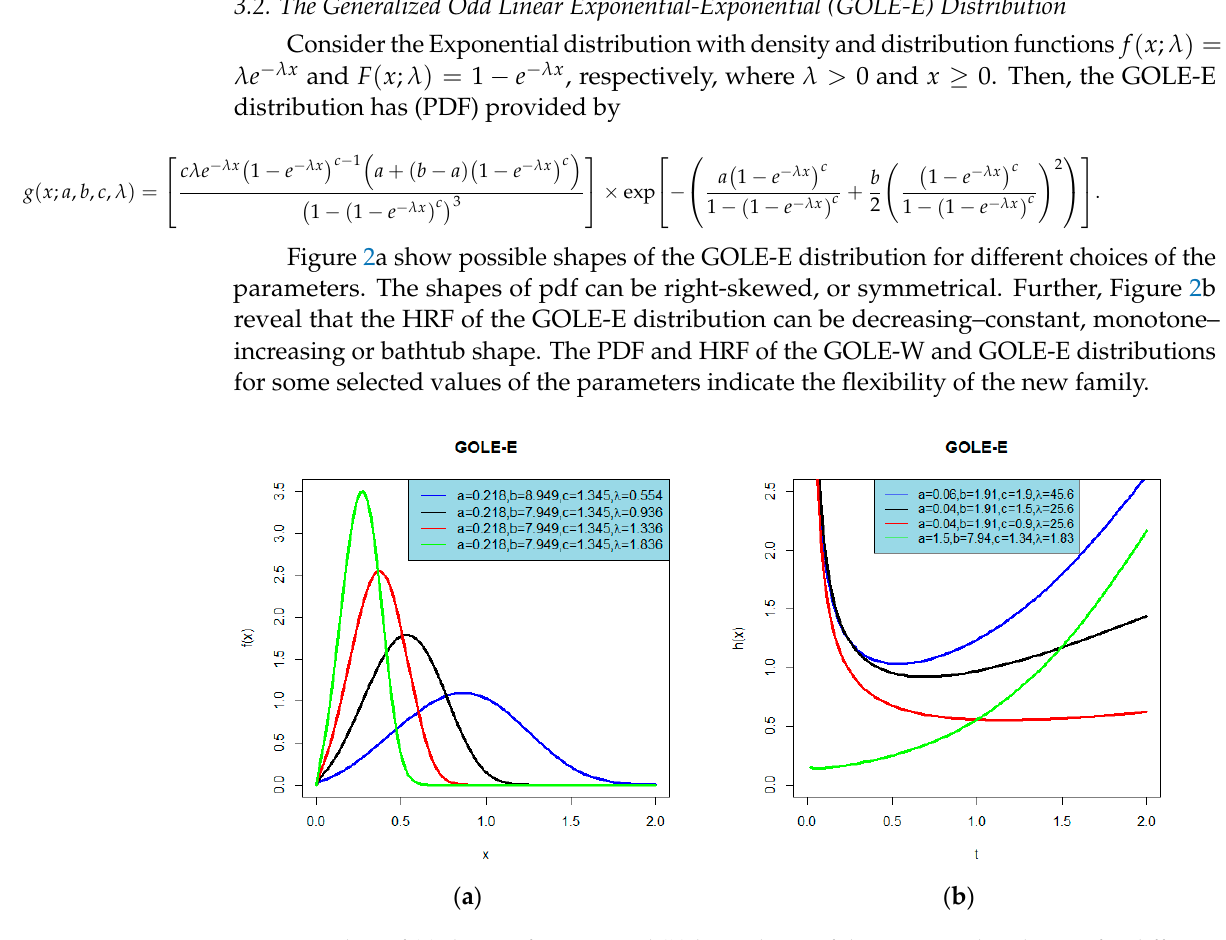
Figure 2. Plots of ( a ) density function and ( b ) hazard rate of the GOLE-E distribution for different parameter values.